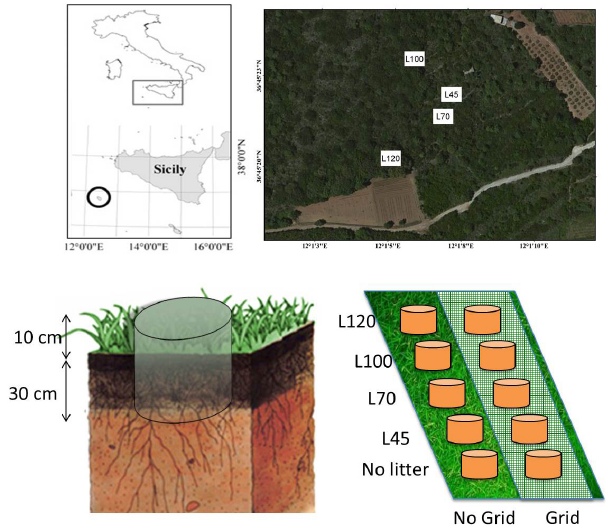
Figure 1. Sampling area of litter in Pantelleria secondary succes- sion (numbers represent litter in field abandoned for 120, 100, 70 and 40 years) and experimental design in meadow field. Numbers indicate the age since